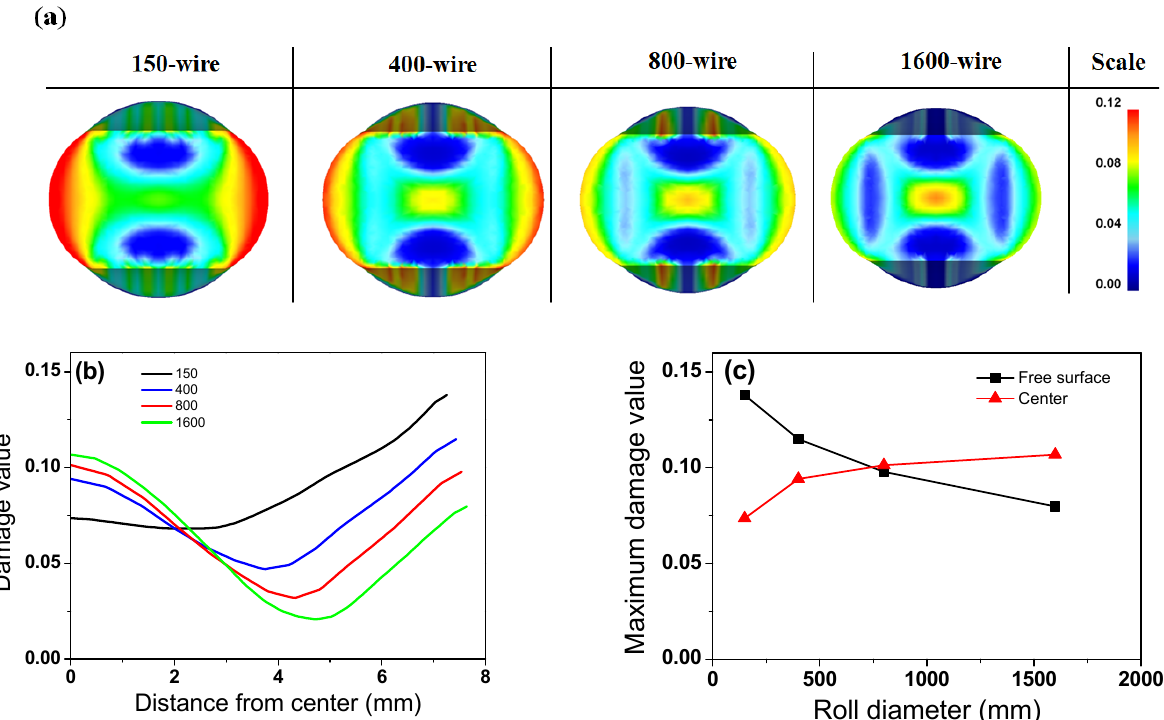
Figure 11. Comparison of the ( a ) contour of the damage value in the wire, ( b ) profile of the damage value along the horizontal direction, and ( c ) the maximum damage value at free surface and center regions with the roll diameter.